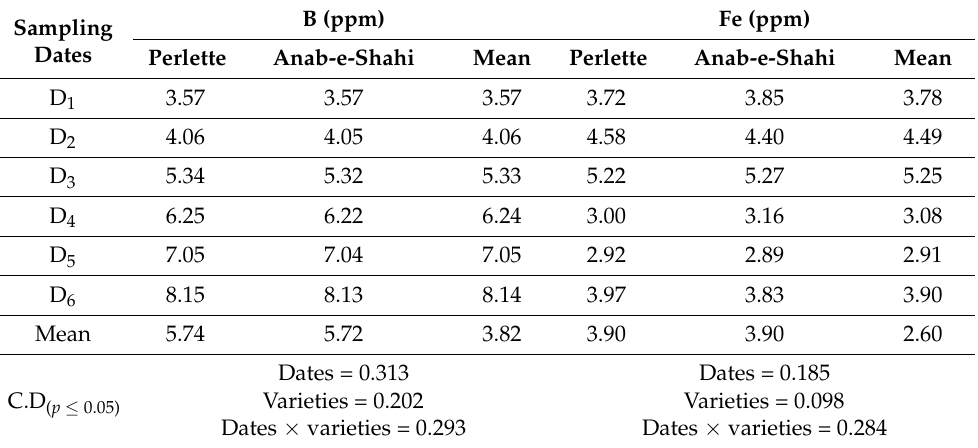
Table 4. Periodic variation of micronutrients (B and Fe) in developing berries of grapes during the growing